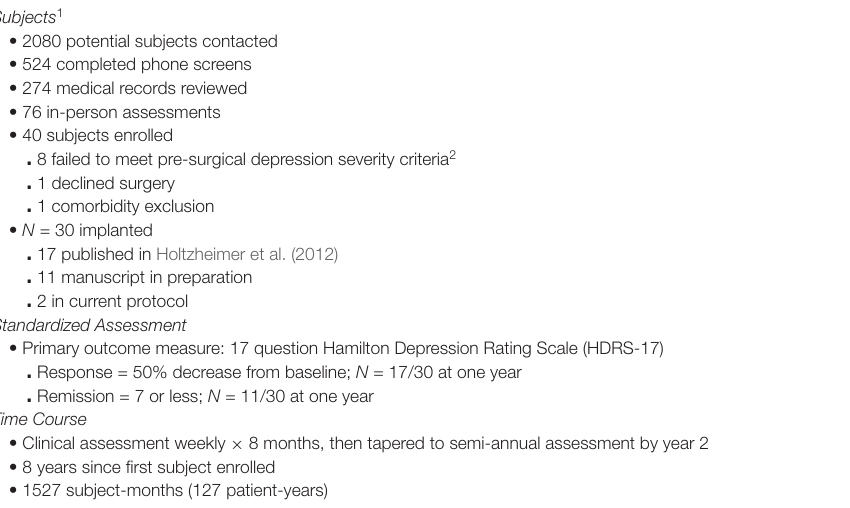
TABLE 1 | Emory SCC DBS for depression experience